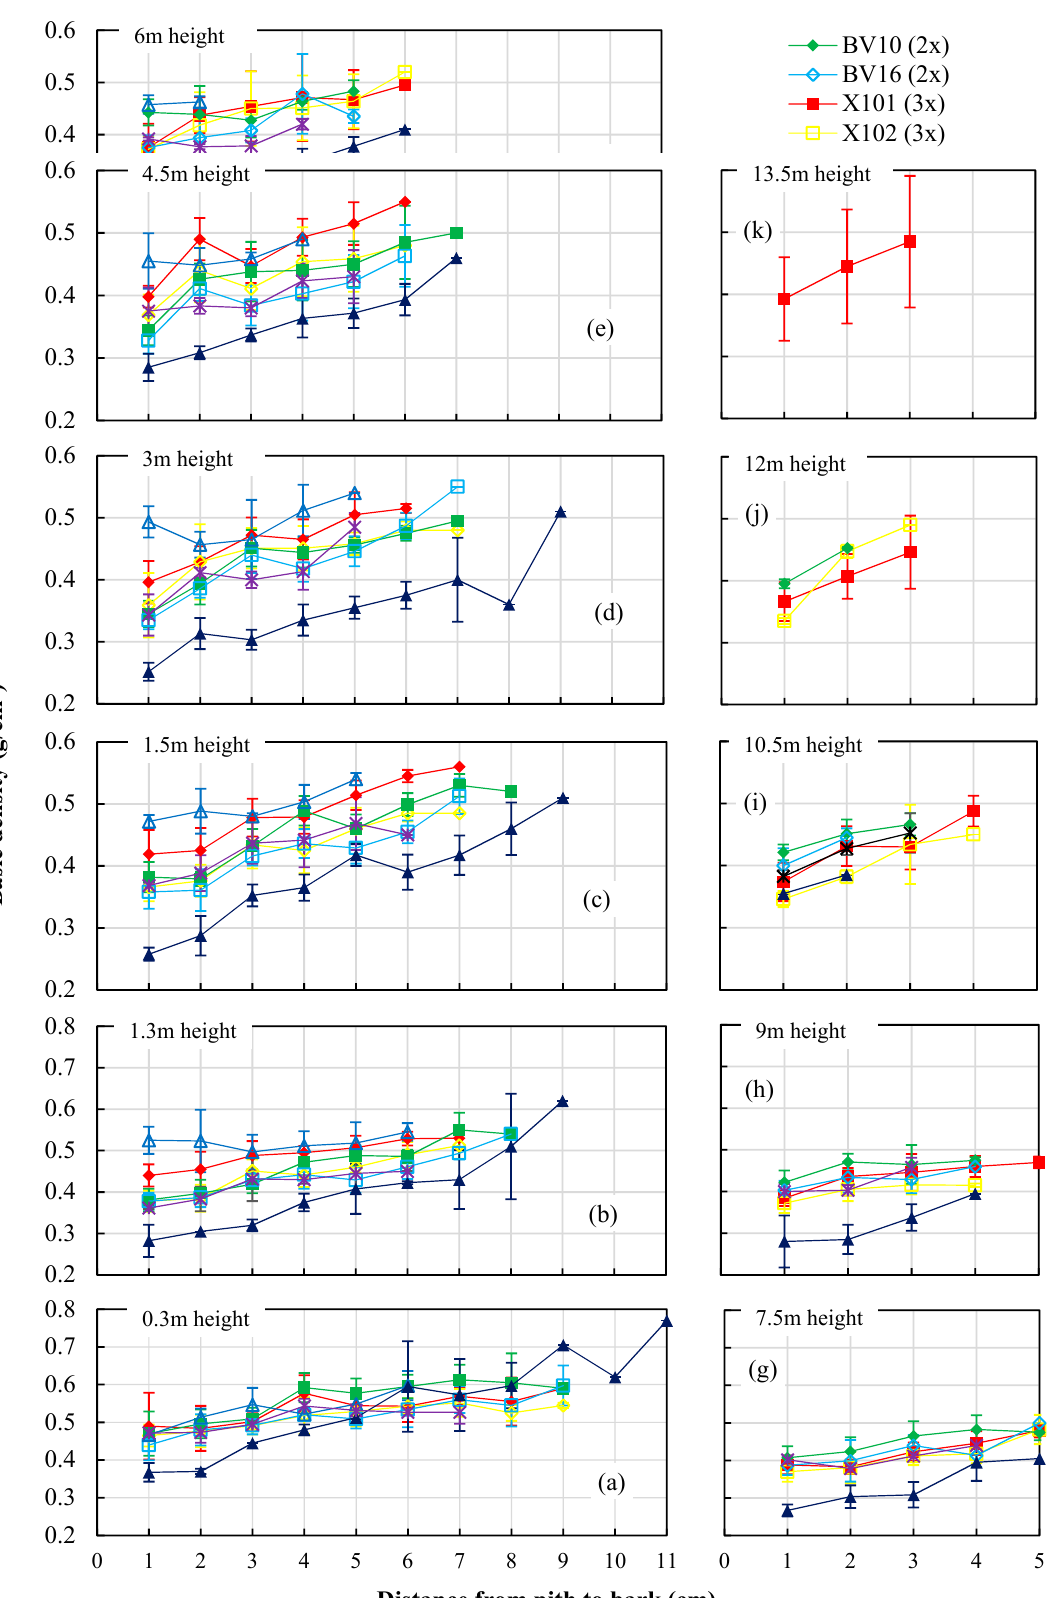
Figure 5. Basic density in the radial direction at different stem heights (bars show standard deviations).